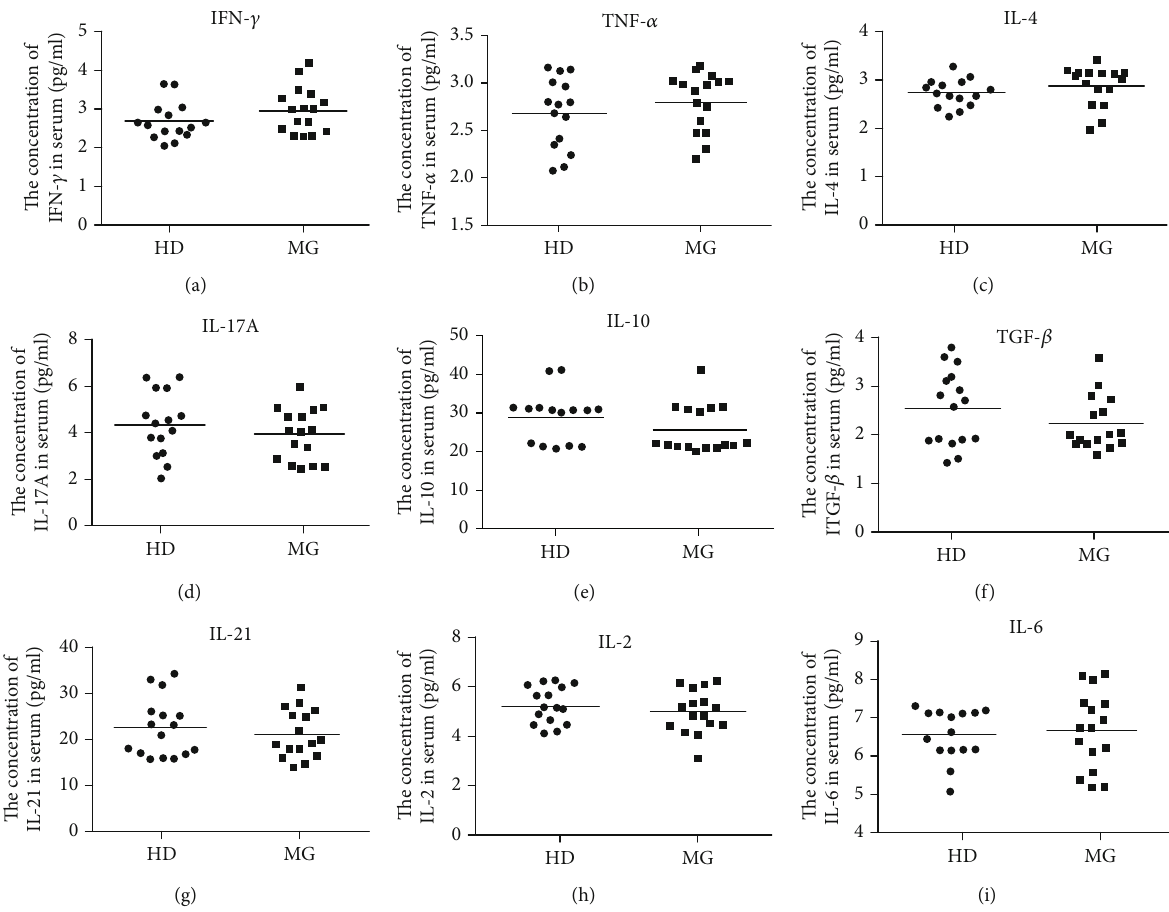
Figure 2: Cytokine pro fi les of CD4 + T cell subset are unchanged in MG patients. The level of cytokines secreted by PBMC from MG patients ( n = 16 ) and healthy donors ( n = 16 ) was measured by ELISA including Th1-associated IFN- γ (a) and TNF- α (b), Th2-secreted IL-4 (c), Th17-speci fi c IL-17A (d), Treg-associated IL-10 (e) and TGF- β (f), Tfh-secreted IL-21 (g), and another two T cell-secreted cytokines IL-2 (h) and IL-6(i). Each data point represents an individual subject. The horizontal lines represent the average